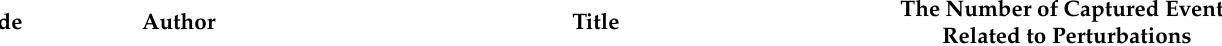
Table 1. The list of eligible